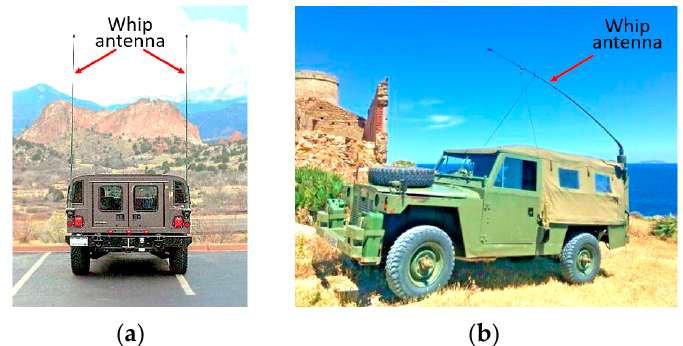
Figure 1. Pictures of whip antennas mounted on vehicles [2,3]: ( a ) straight and ( b ) bent.